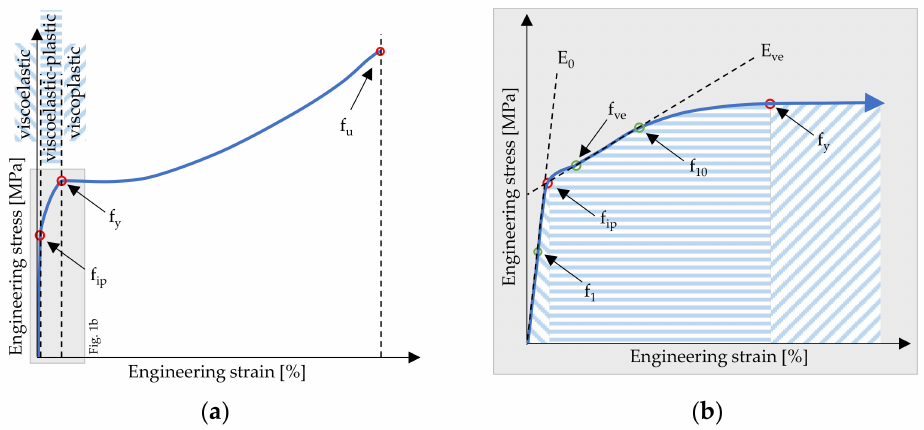
Figure 1. ( a ) Stylized illustration of a uniaxial stress-strain diagram of ETFE foils and ( b ) stylized illustration of a uniaxial stress-strain diagram of ETFE foils at relatively small strains (cut shortly after the yield point f y